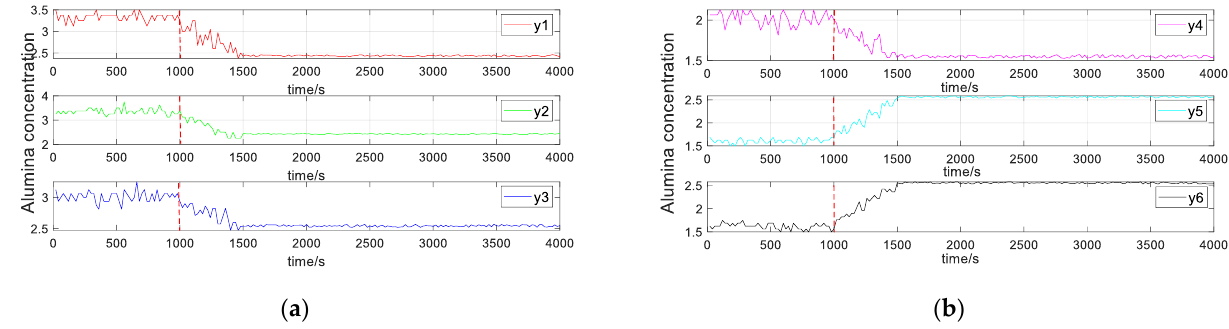
Figure 7. Variation of alumina concentration: ( a ) subsystems 1 – 3; and ( b ) subsystems 4 – 6.